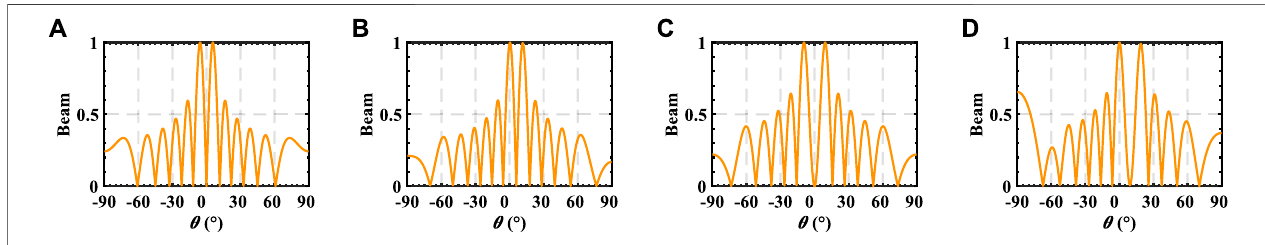
FIGURE 7 | Phase distribution of the observation plane perpendicular to the Z -axis and the beam axis after beam collimation. (A) Observation plane perpendicular to the Z -axis for ( r , ϕ ) (cid:1) ( 1 . 25 m , 0 ° ) , ( r t , θ t , ϕ t ) (cid:1) ( 1 . 25 m , 0 ° , 0 ° ) ; (B) observation plane perpendicular to the beam axis for ( r , ϕ ) (cid:1) ( 1 . 25 m , 0 ° ) , ( r , θ , ϕ ) (cid:1) ( 1 . 25 m , 0 ° , 0 ° ) ; (C) observationplaneperpendiculartothe Z -axisfor ( r , ϕ ) (cid:1) ( 2 . 5 m , 0 ° ) , ( r t t t plane perpendicular to the beam axis for ( r , ϕ ) (cid:1) ( 2 . 5 m , 0 ° ) , ( r t , θ t , ϕ t ) (cid:1) ( 2 . 5 m , 0 ° , 0 ° )